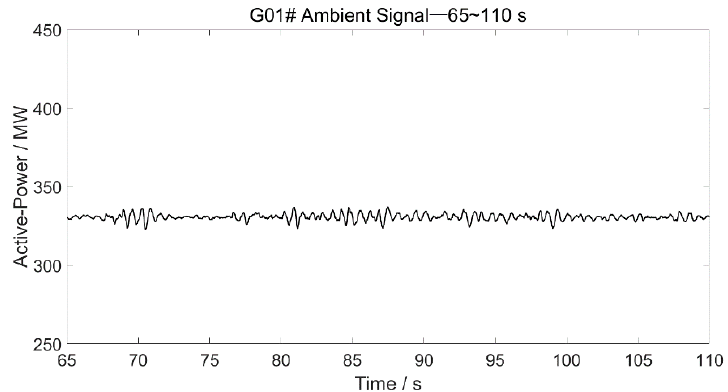
Figure 6. Obvious oscillation signal collected. Figure 7. Ambient noise signal collected. Figure 7. Ambient noise signal collected.